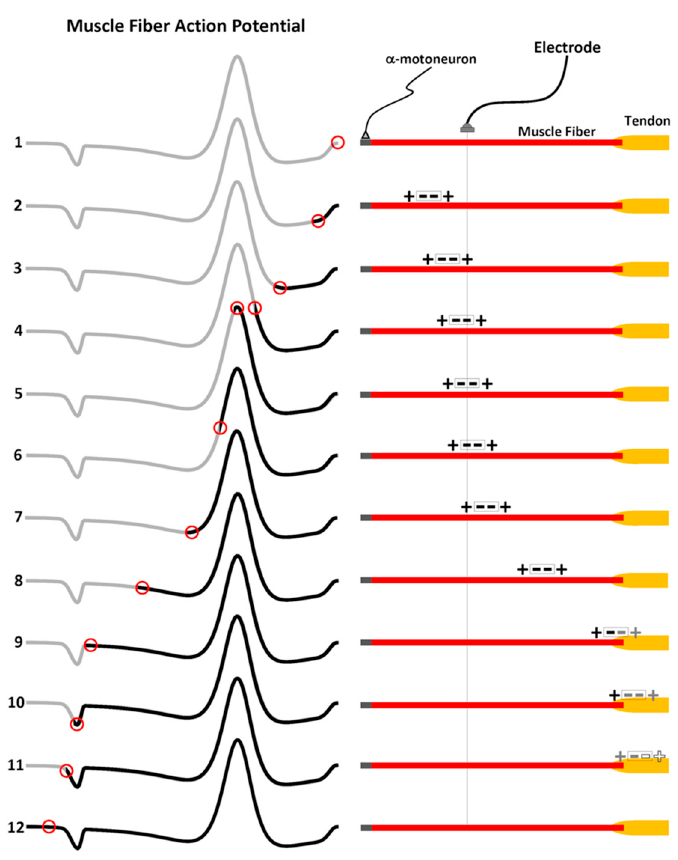
Figure 5. The development of the non-propagating component of the muscle fiber action potential (MFAP) is shown in the left panels, and the travelling double dipole (or, quadrupole) is depicted in the right panels. As the quadrupole propagates from left to right, there is an increase in the length of the thick black line over the grey trace of the MFAP to simulate its progression. The red circle on the MFAP shows the potential recorded at the electrode due to the travelling quadrupole. The convention for the polarity of the MFAP is positive below the horizontal and negative above the horizontal.